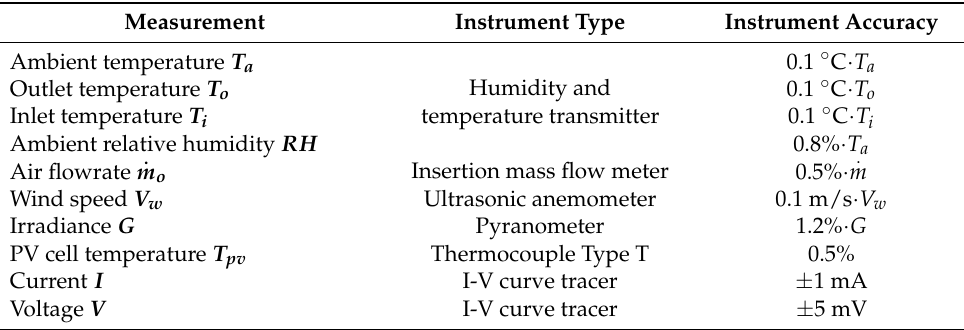
Figure 7. Outdoor experimental setup schematic. Table 7. Range of the different measurements during the outdoor steady ‐ state experiment.